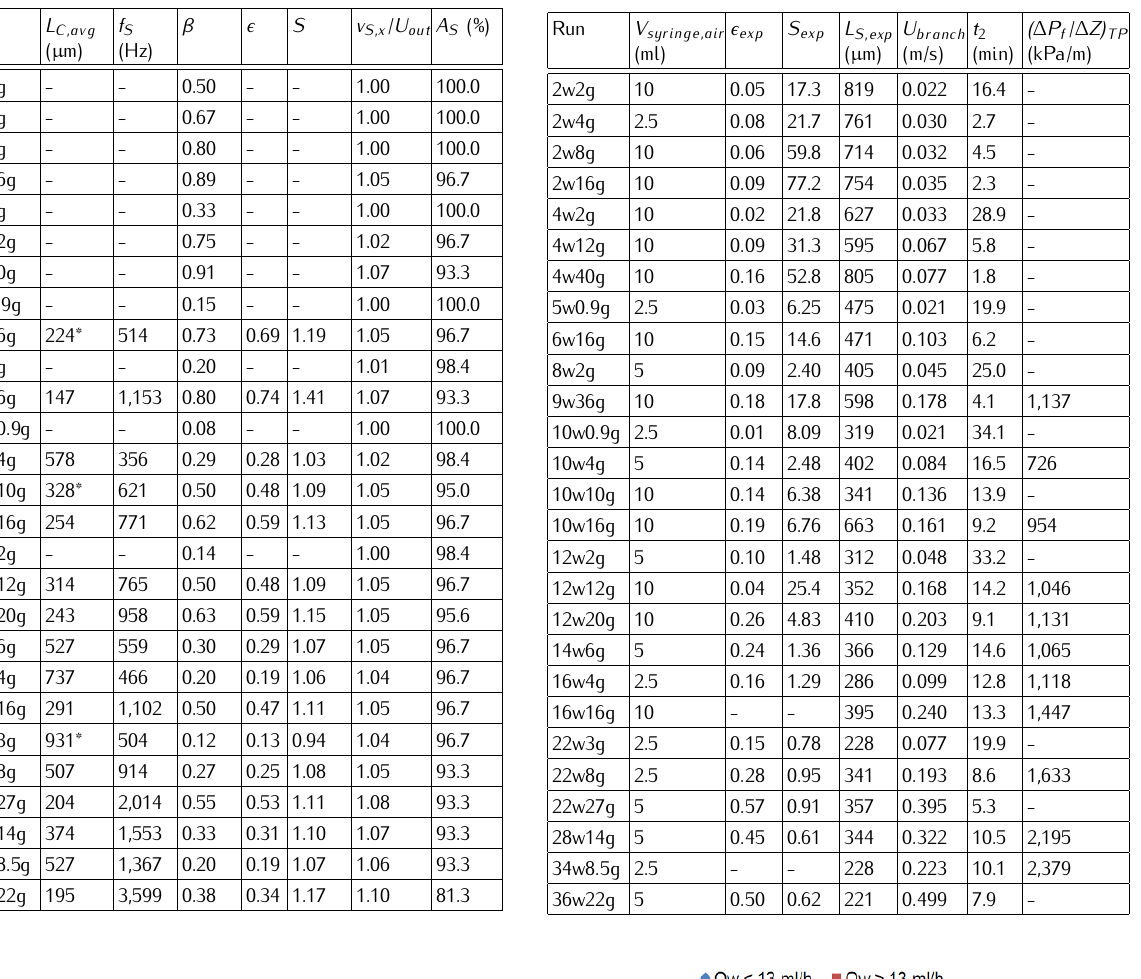
Table 3. Numerical simulation calculated results Table 4. Experimental data